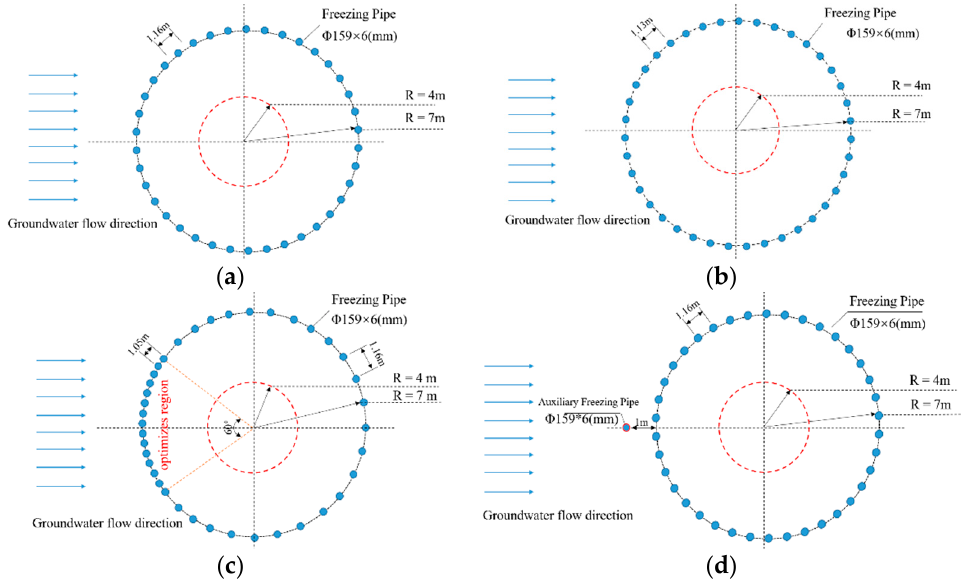
Figure 10. Schematic diagram of optimal layout scheme of freezing holes. ( a ) Original scheme; ( b ) Optimization scheme 1; ( c ) Optimization scheme 2; ( d ) Optimization scheme 3.